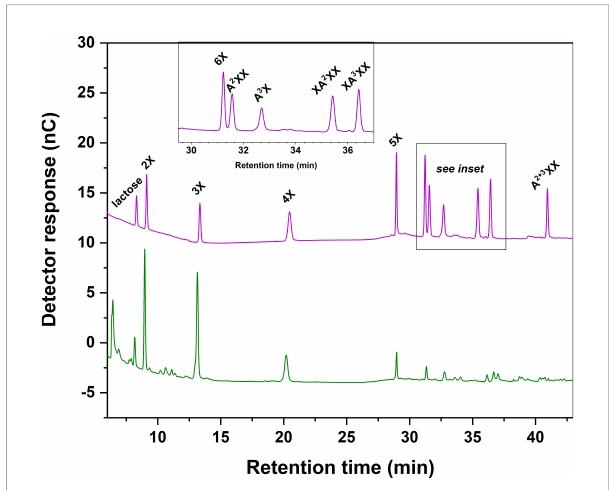
FIGURE 2 Chromatographic separation of linear xylooligosaccharide (XOS) and branched arabinoxylan oligosaccharide (AXOS) compounds using high-performance anion-exchange chromatography with pulsed amperometric detection (HPAEC-PAD). Upper chromatogram and inset: XOS and AXOS standards and lactose internal standard. Lower chromatogram: Endoxylanase hydrolysate of insoluble cell wall material from timothy grass ( Phleum pratense L., cultivar ‘ Clair ’ ) vegetative tissue. Please refer to Figure 1 for chemical structures corresponding to standard compounds ’